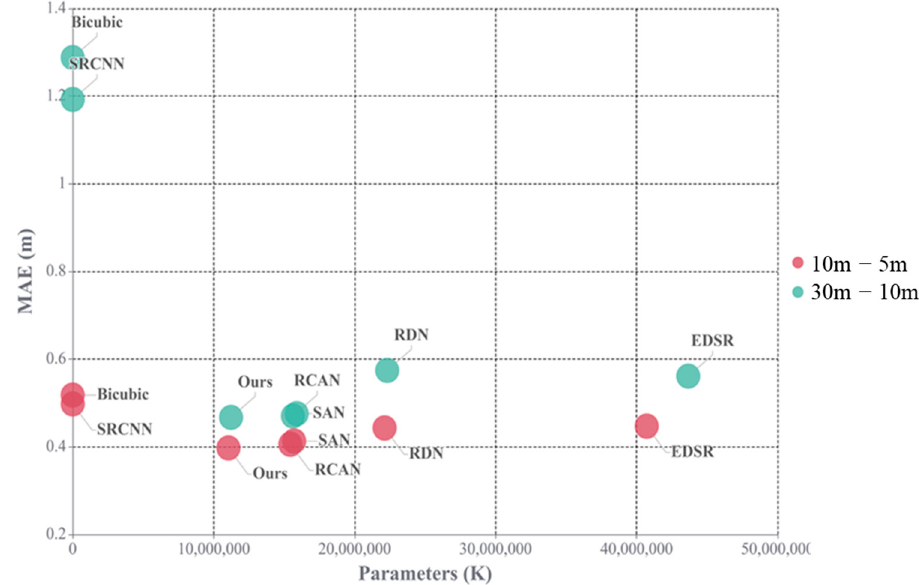
Figure 8. The efficiency of some state-of-the-art SR methods. To assess the visual performance, we visualized the low-resolution images and the corresponding high-resolution images in the validation datasets as the raw input and ground truth of the methods, and the DEMs after reconstruction using different SR models, as shown in Figures 9a and 10a. There are minor differences in the MAE that are visible when we zoom into and show area A in Figure 9b and area B in Figure 10b. Compared to these benchmark methods, our proposed architecture generally shows the best reconstruction performance for different scales. Overall, both the quantitative and qualitative results confirm the efficacy of the ERFFN.